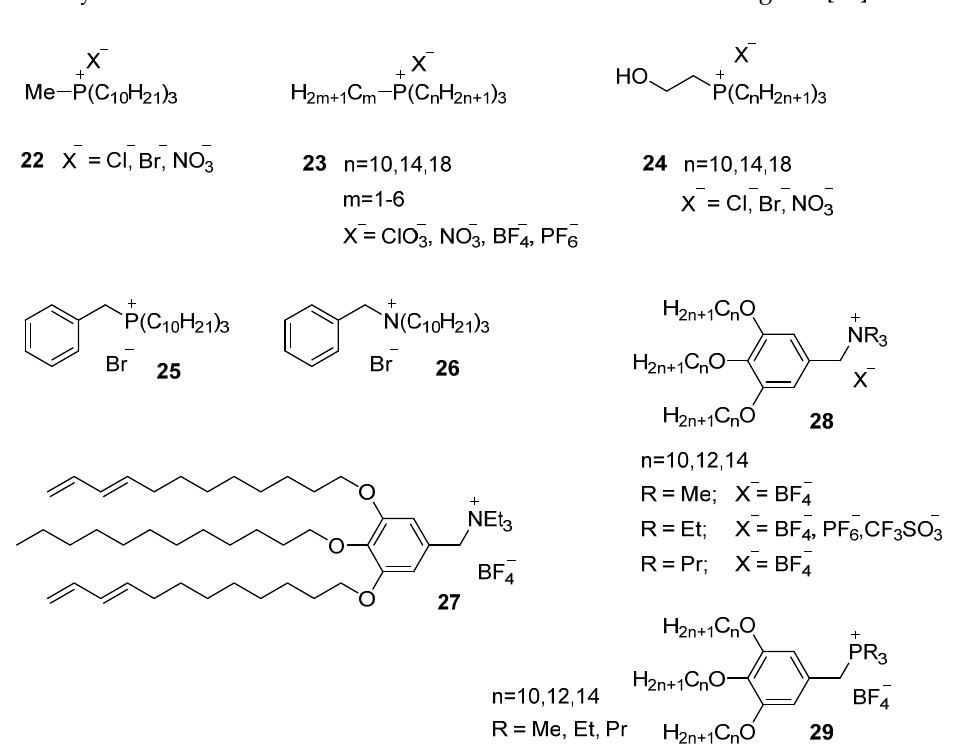
Figure 6. Ammonium and phosphonium-based ILCs with three or four aliphatic tails that are either substituted directly to the cation ( 22 – 26 ) or connected through an aromatic spacer ( 27 – 29 ).